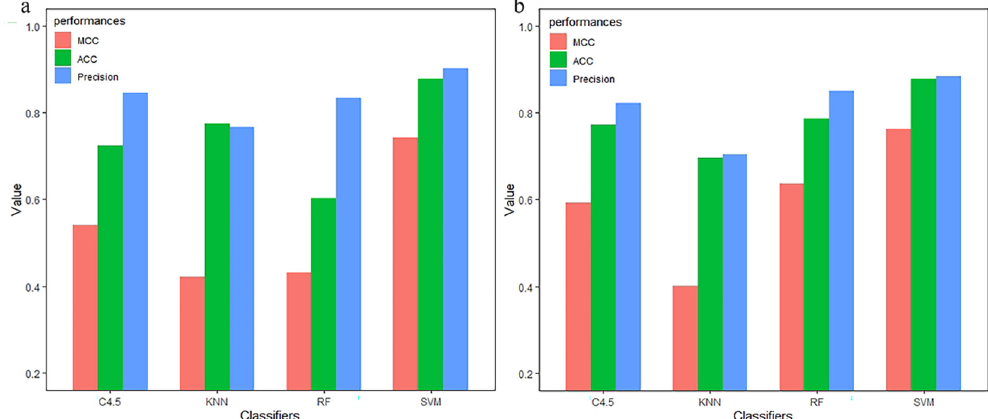
Figure 6. Two independent test set used the monoTriKGap feature extraction method to predict the performance evaluation of immunoglobulin under different classifiers ( a , b ).